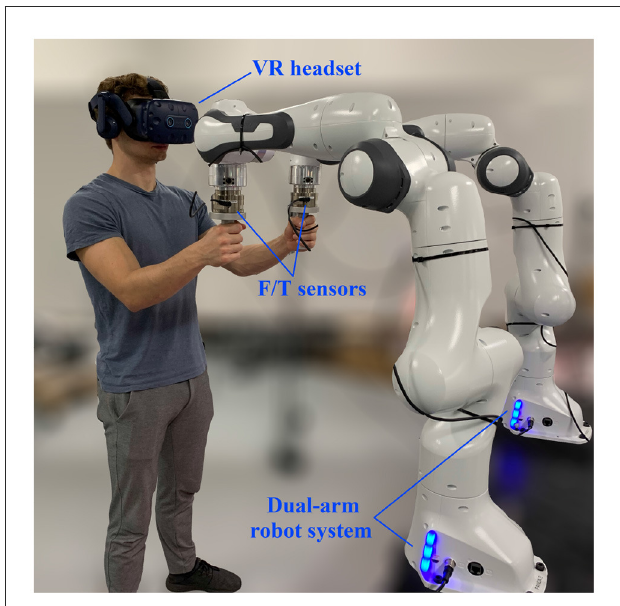
FIGURE1 Setup of PREDICTOR consisting of a dual-arm robot system (Franka Emika Panda) and a VR headset (HTC VIVE Pro